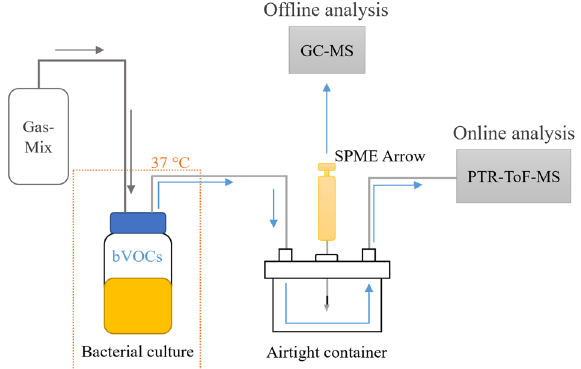
Figure 1. Schematic representation of the sampling process. Anaerobic gas-mixture flows through the bacterial culture headspace into a container, where the SPME sample is taken, and excess moisture is collected. PTR- ToF–MS instrument measures the concentrations of VOCs in the headspace and GC–MS is used for their identification. Bacterial cultures are incubated at 37 °C, but otherwise the setup is in room